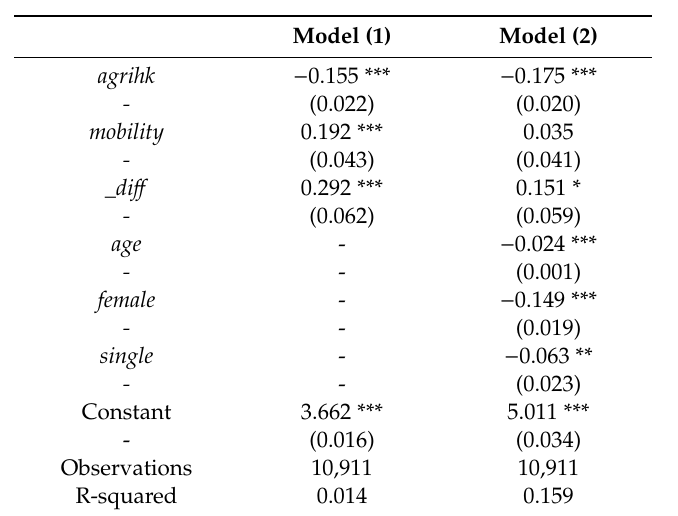
Table 5. The Di ff erence-in -Di ff erence (DID) construction and the numeric